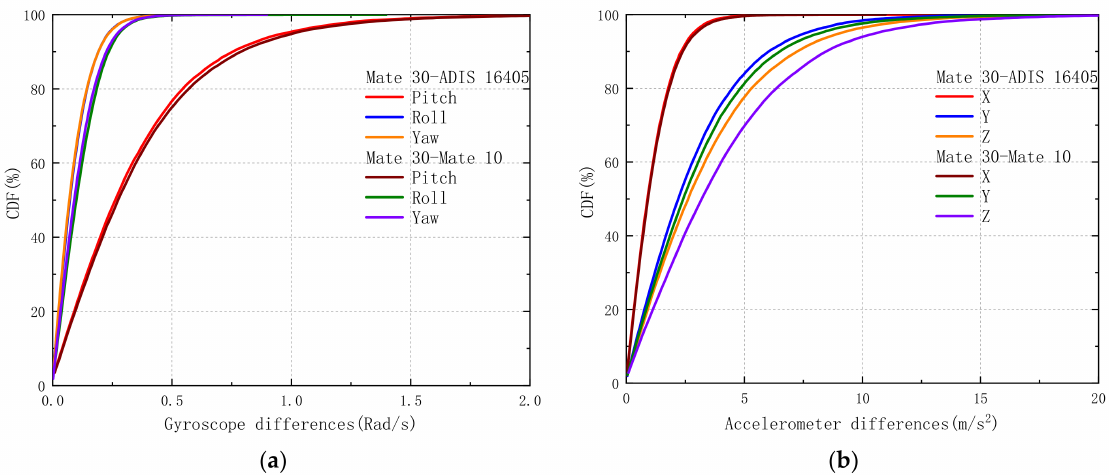
Figure 9. Comparison of cumulative distribution function (CDF) of three-axis gyroscope and ac- celerometer differences from Mate 30, ADIS16405, and Mate 10. ( a ) Three-axis gyroscope; ( b ) three- axis accelerometer. Mate 30–ADIS16405 denotes the CDF of gyroscope and accelerometer differences between Mate 30 and ADIS16405, and Mate 30–Mate 10 denotes the CDF of gyroscope and accelerom- eter differences between Mate 30 and Mate 10.